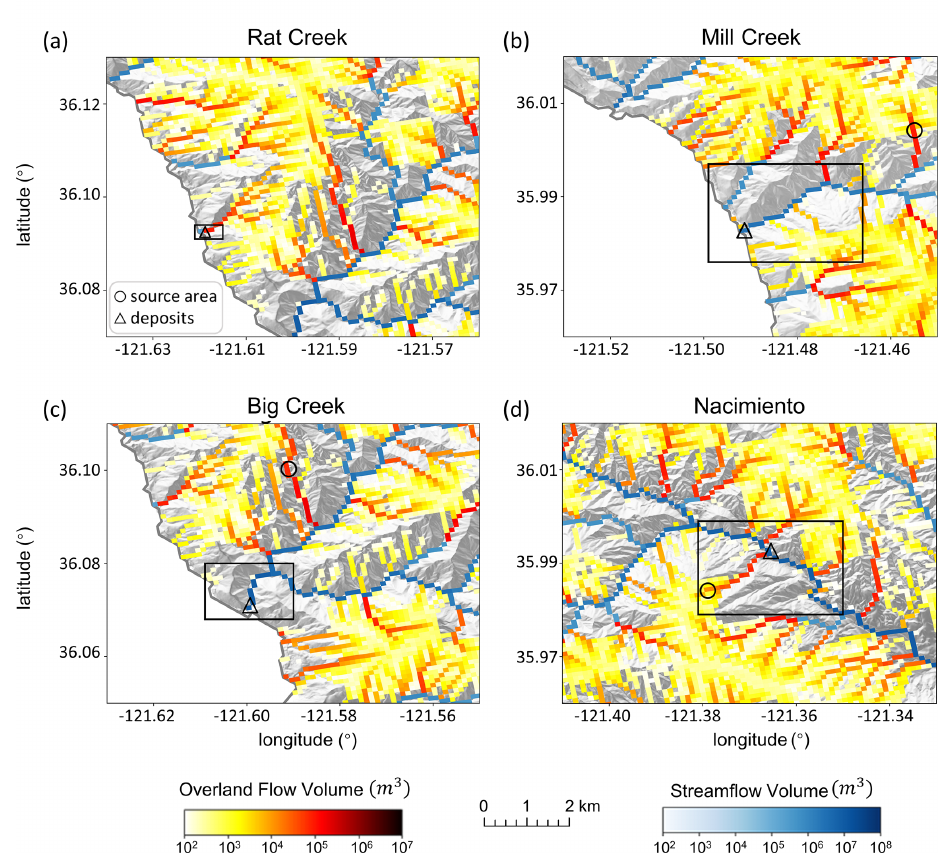
Figure 7. WRF-Hydro-simulated overland flow and streamflow in the burn scar simulation. (a–d) Total volume of accumulated overland flow (m 3 ; yellow–red shading) and streamflow (m 3 ; blue shading) between 27 January 00:00 and 28 January 12:00 at four debris flow sites draped over a hillshade of topography. Black rectangles correspond to domains in Fig. 3a–d. Black circles and triangles indicate debris flow source areas and deposits,